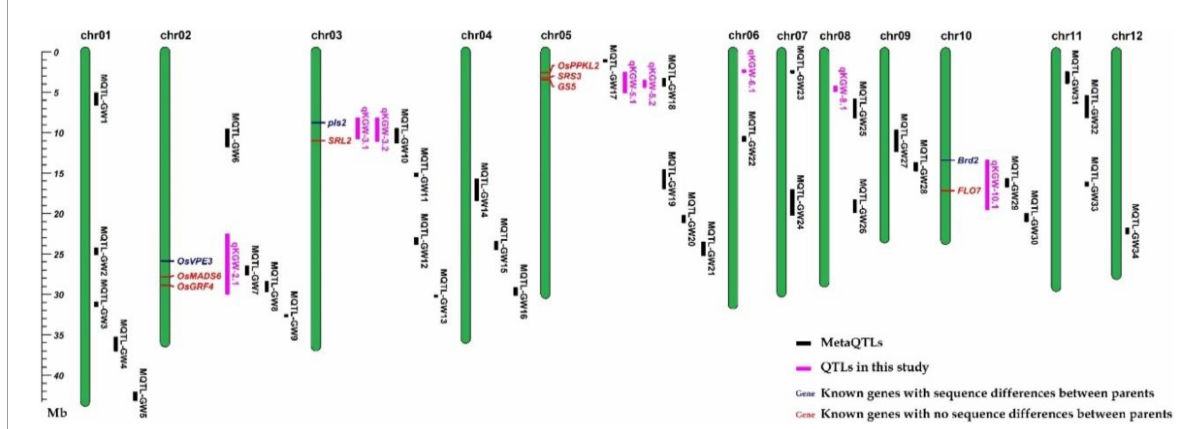
FIGURE3 The positions of QTLs, MetaQTLs, and known KGW-related genes.